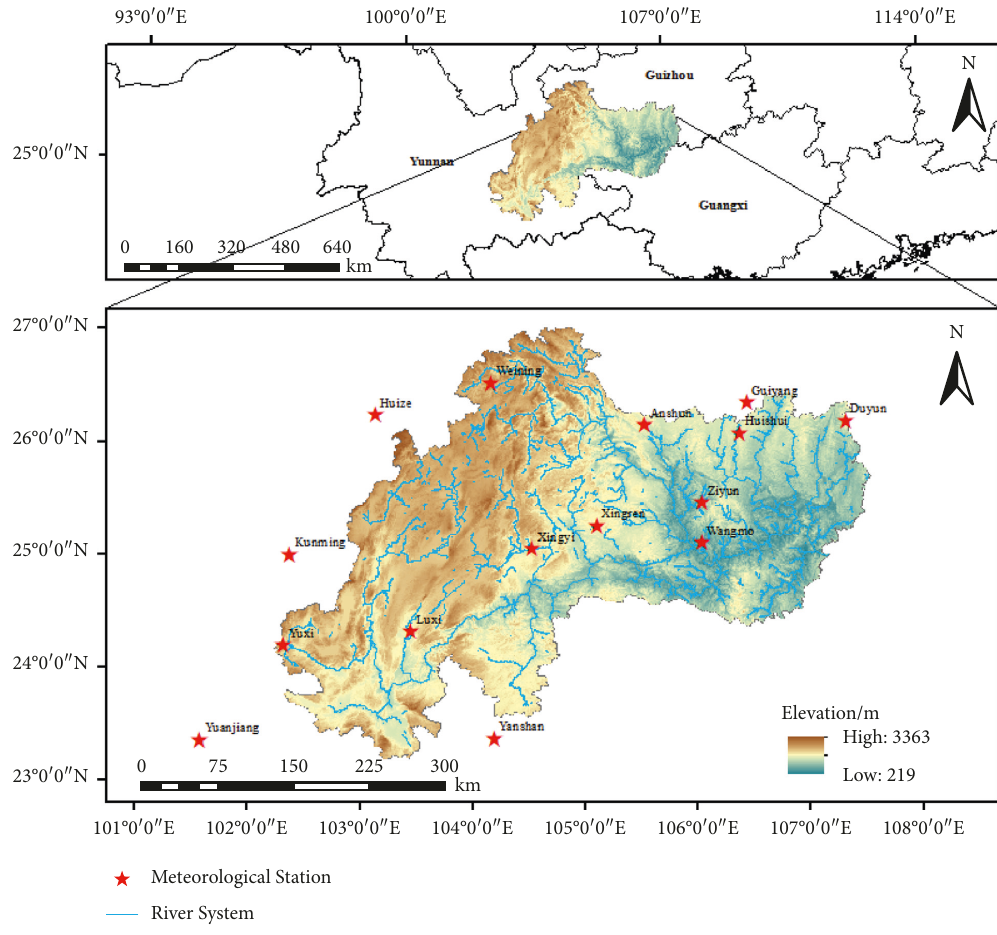
Figure 1: Distribution of main river systems and stations.